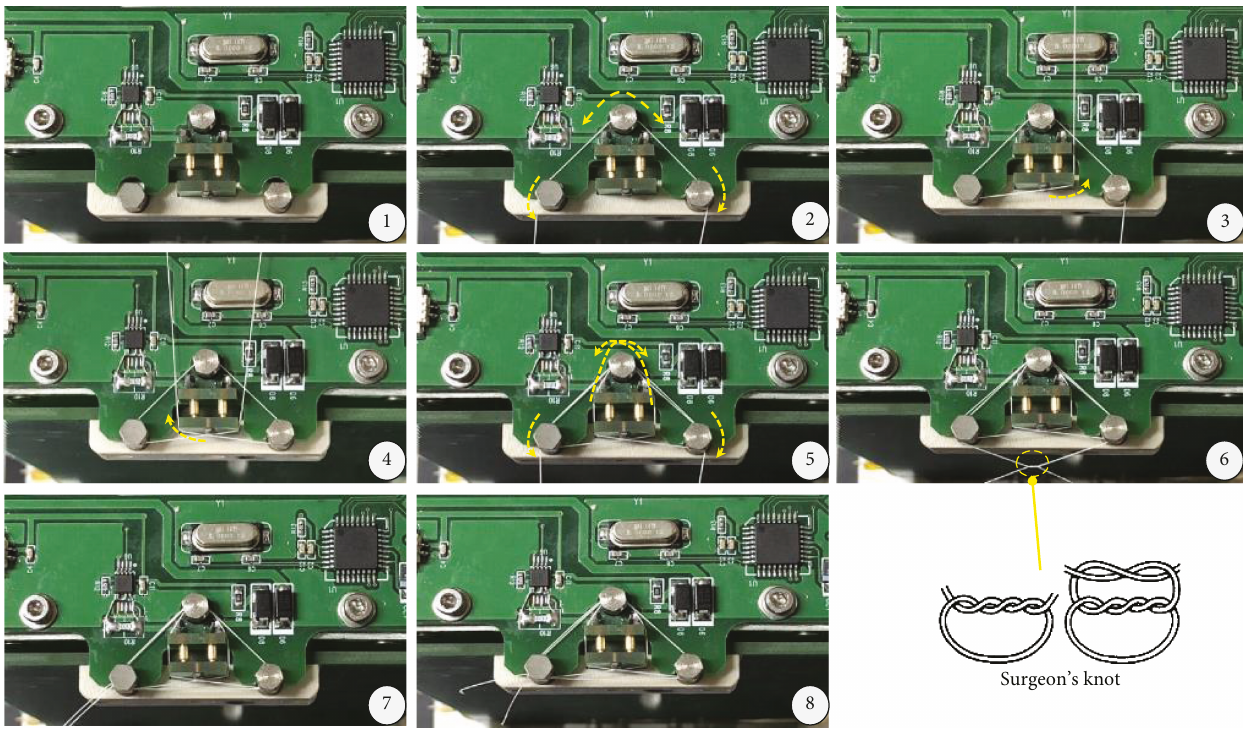
Figure 4: Tightening process of nylon wire.